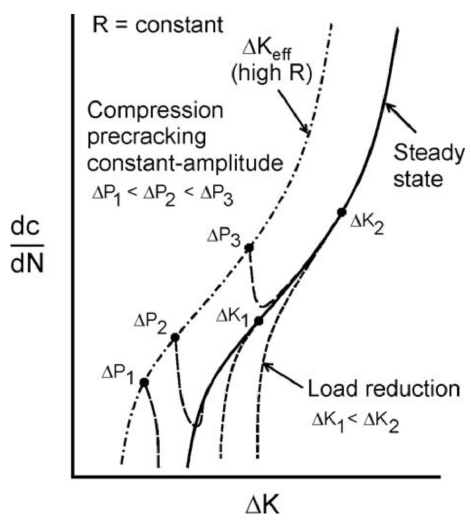
Figure 13. Typical FCG curves generated by the compression precrack constant amplitude method and load-shedding method [30].